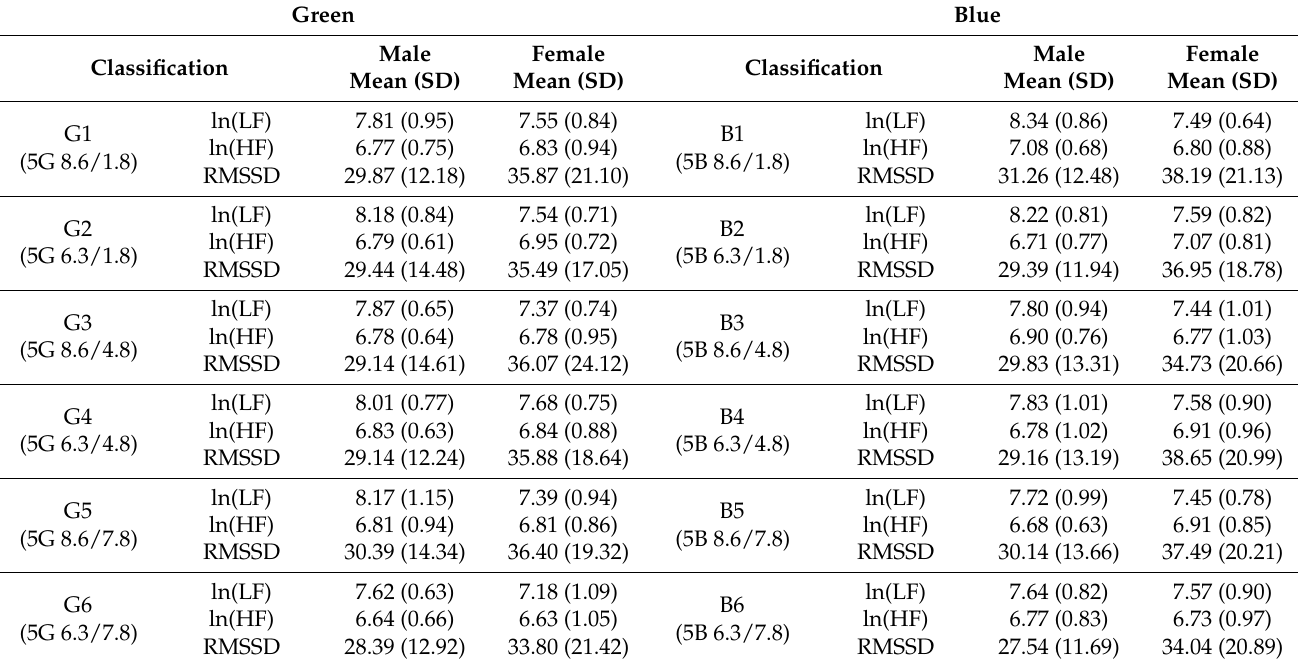
Table 7. Average ln(LF), ln(HF), and RMSSD parameters for each environmental